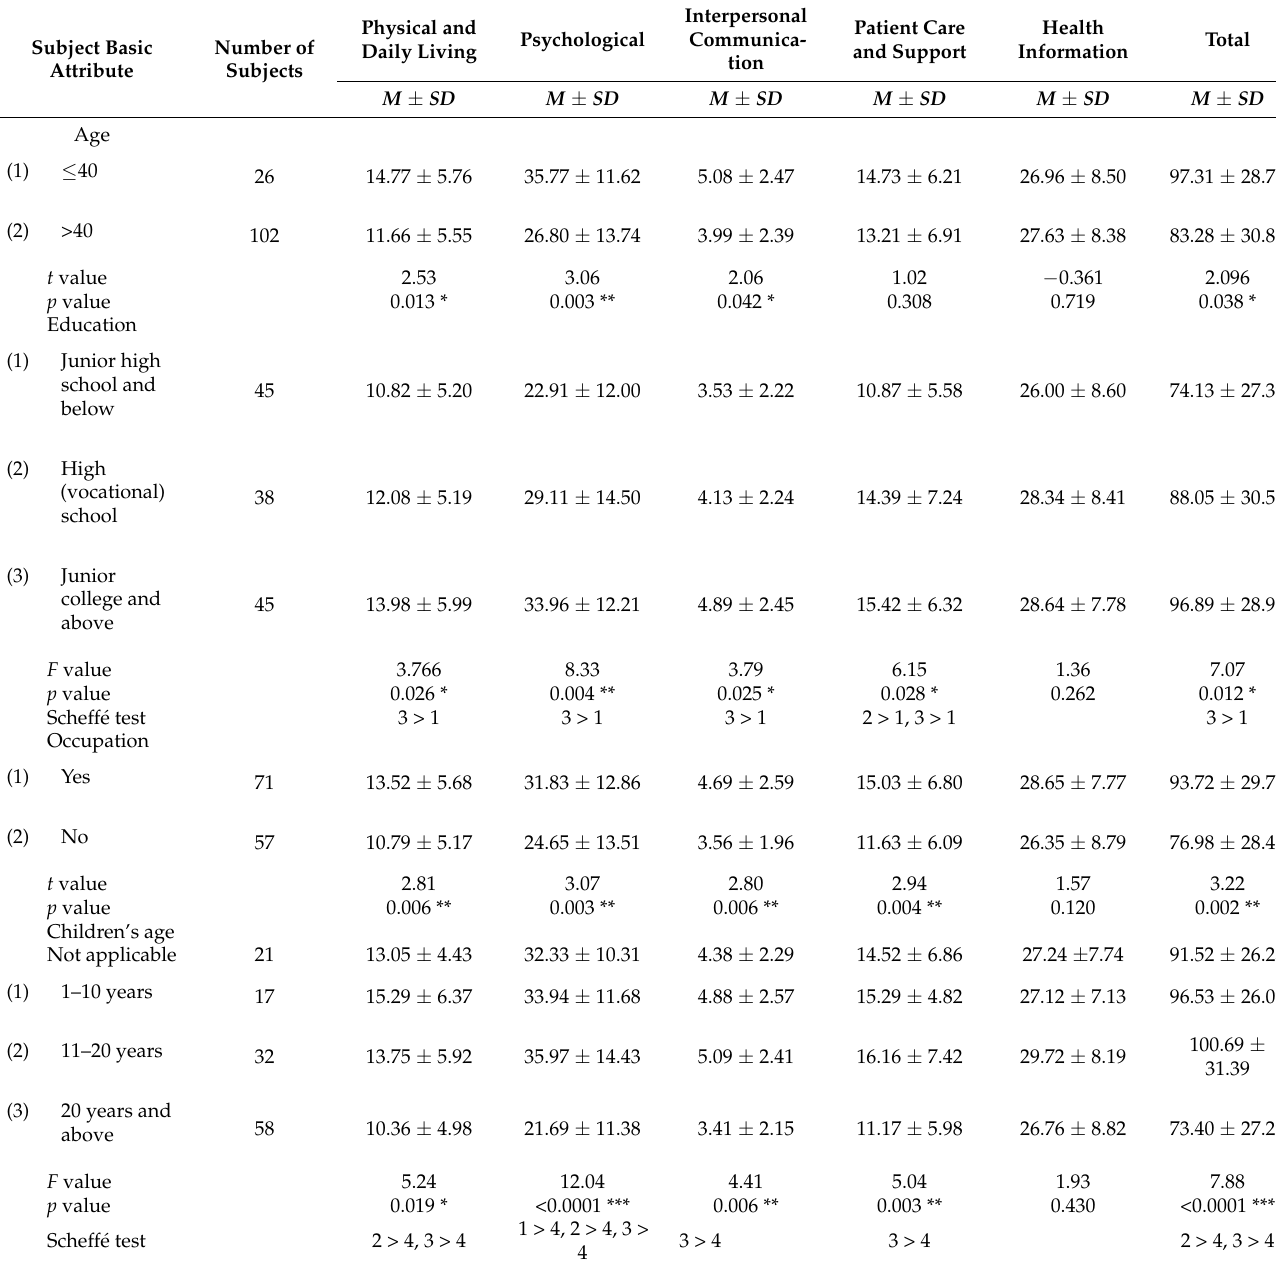
Table 1. Differences in unmet care needs between subjects’ basic attributes ( n =